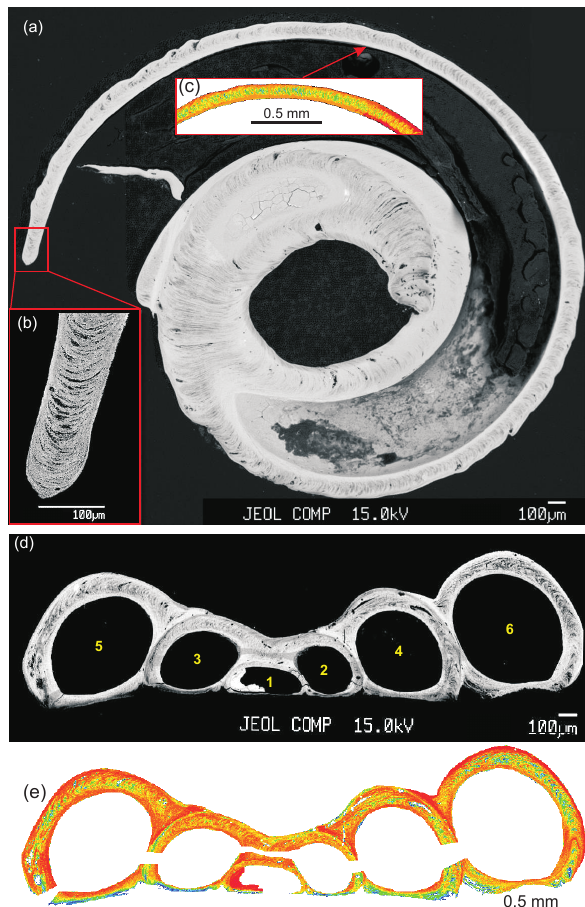
Figure 6. Backscatter SEM images (BEI) and electron microprobe (EMP) calcium maps of embedded and polished S. spirorbis speci- mens from the winter control experiment. (a) Cross section viewed from shell bottom. (b) Detail from area in red frame, outer wall at the tube mouth showing convex forward lamellae (chevron struc- ture). (c) EMP calcium map of upper-right tube wall showing densely calcified outer layers along the inner and outer rim (red, high calcium concentration). Inner parts of tube wall are lami- nated and less calcified (yellow-green, low calcium concentration). (d) Longitudinal cross section. Numbers indicate order of tube whorls. 1: juvenile tube, partly filled with secondary dense mate- rial (left). 6: final whorl, added during the experiment. (e) Calcium EMP map showing densely calcified wall rims and laminated less calcified wall fillings. Later whorls partly coat the older tube with a thick calcium-rich shell layer. White areas cutting the tube walls are artefacts of data acquisition.